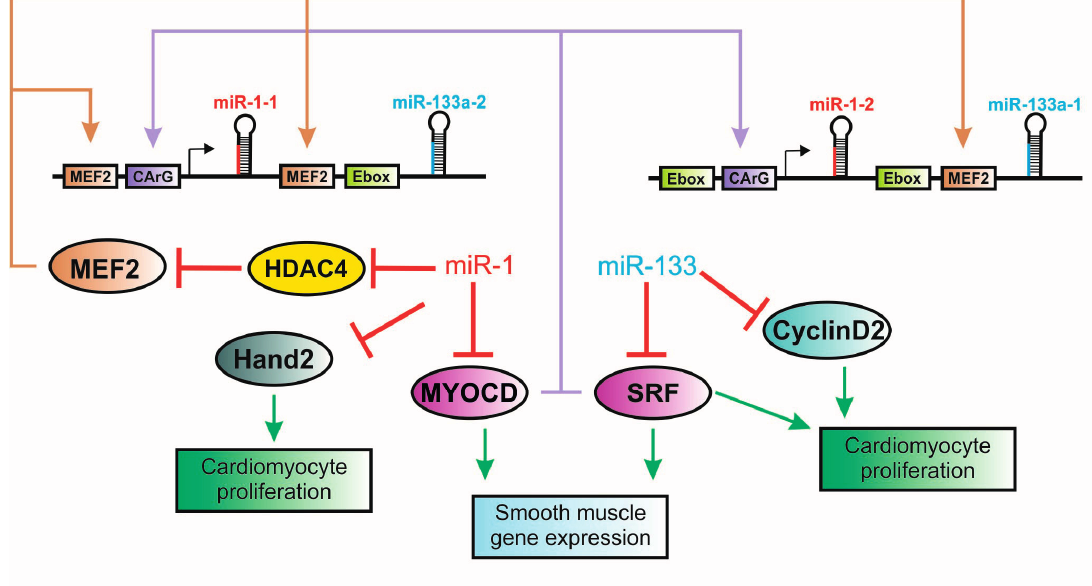
and control cardiac progenitor cell proliferation and differentiation, miR-1 and miR-133 fine-tune multiple nodes of the genetic networks that control cardiac muscle